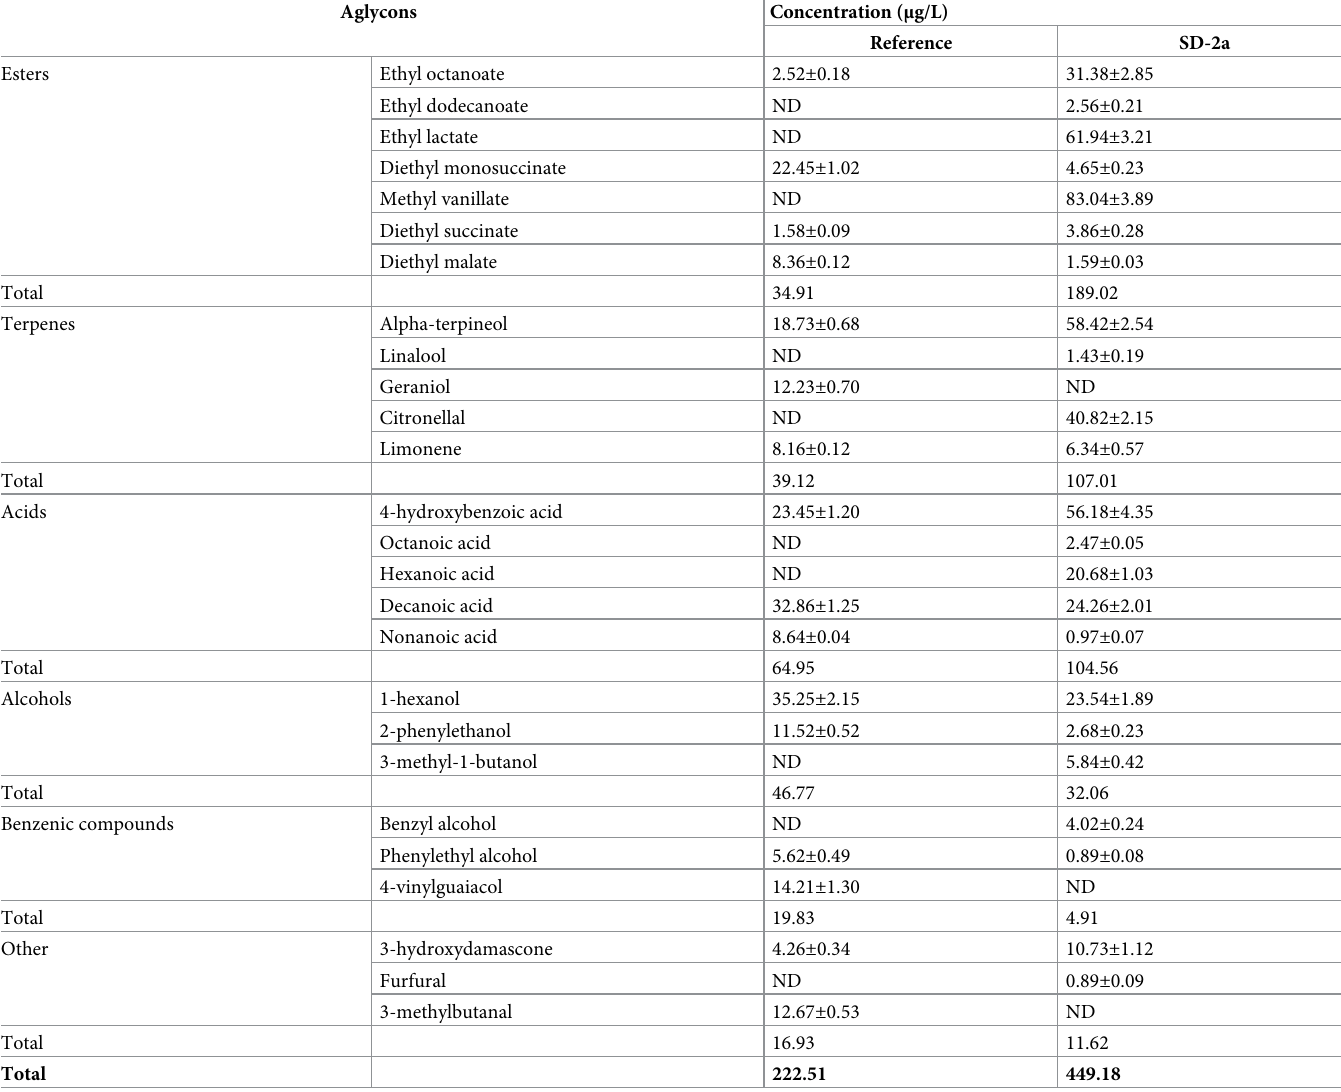
Table 2. Aglycones released from natural precursors by O . oeni SD-2a in synthetic wine after